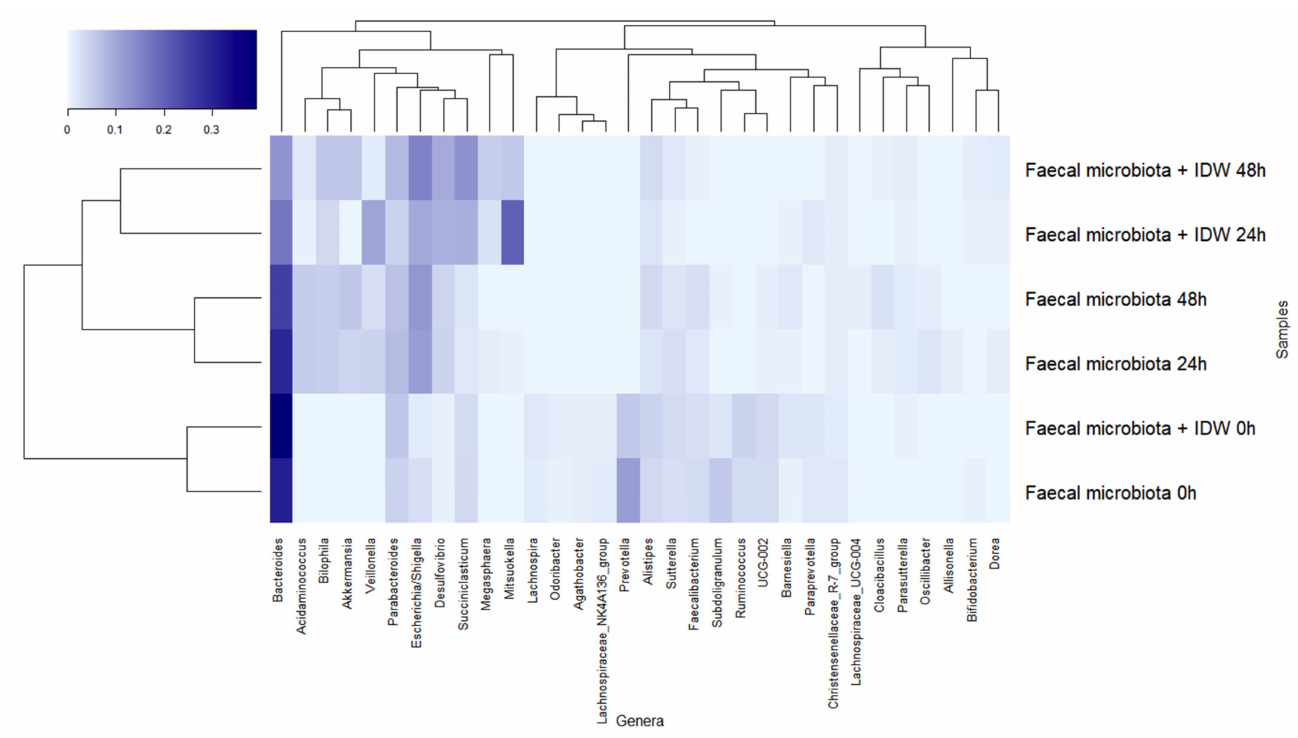
Figure 5. Evolution of bacterial genera with relative abundance higher than 1% during fecal fermentations in the absence and in the presence of intestinal-digested wine (IDW).